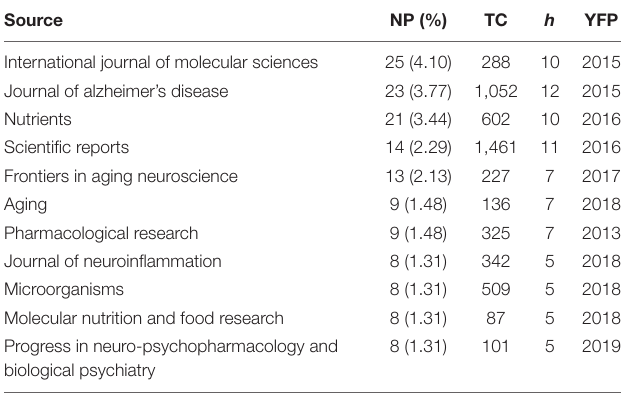
TABLE 2 | A list of journals with the highest number of publications (NPs) on the subject in our collection.